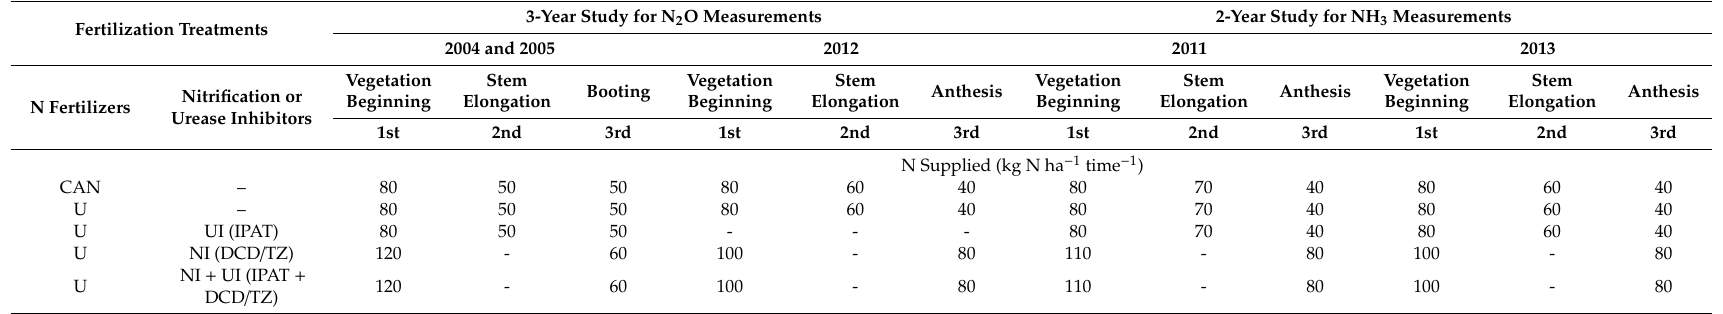
Table 2. Nitrogen fertilization strategies (CAN: calcium ammonium nitrate; U: urea; NI: nitrification inhibitor; and UI: urease inhibitor) for field experiments in 2004, 2005, and 2012 for N 2 O measurements and in 2011 and 2013 for NH 3 measurements,